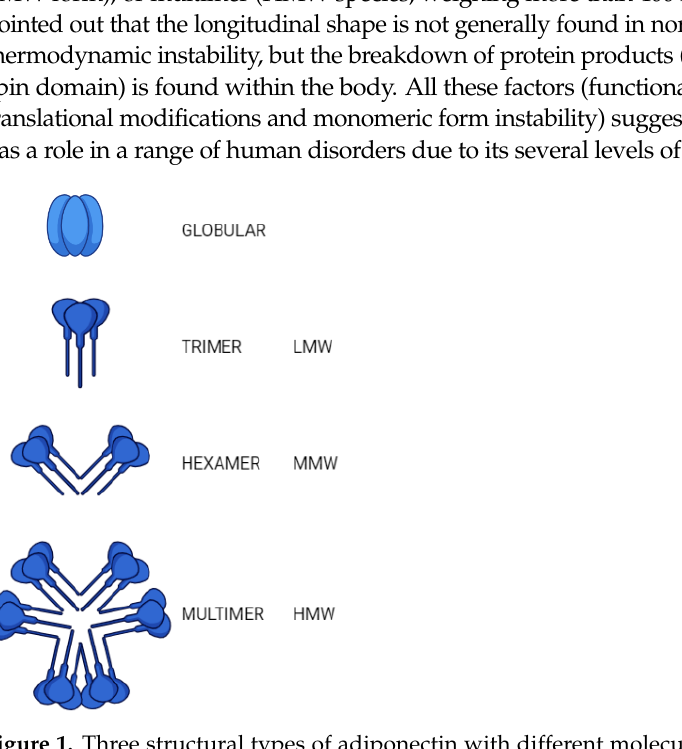
Figure 1. Three structural types of adiponectin with different molecular weight (trimer, hexamer, and multimer). A full-length adiponectin (~30 kDa) consists of a globular domain, a collagenous domain, a species-specific domain, and a signal peptide. Oligomerization facilitates the formation of the trimer, hexamer, and high-molecular weight (HMW) adiponectin. Full-length adiponectin can undergo proteolytic cleavage, whose proteolytic fragment corresponds to the globular adiponectin. AdipoR1 has a greater affinity for the globular form, whereas AdipoR2 has a moderate affinity for both globular and full-length